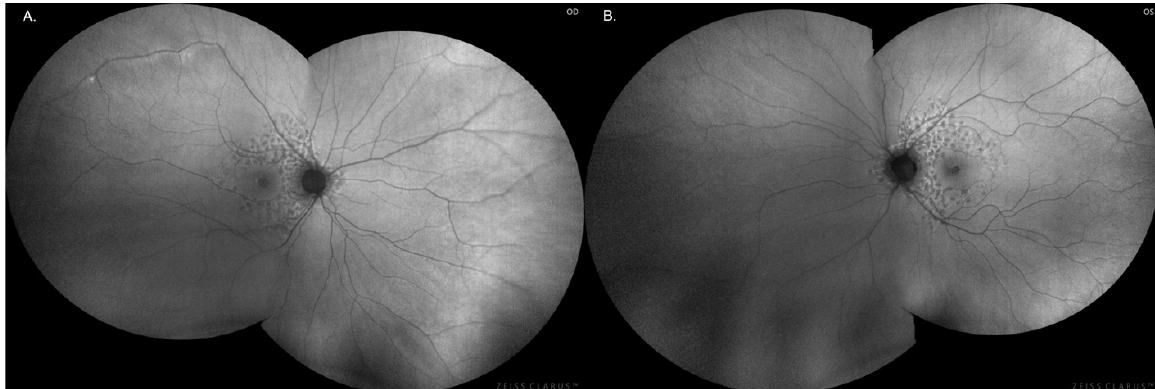
Figure 3. Fundus imaging in the right eye ( A ) and left eye ( B ), respectively. Reticular pattern of pigment epithelial hyperpigmentation morphologically like a fishing net with knots.